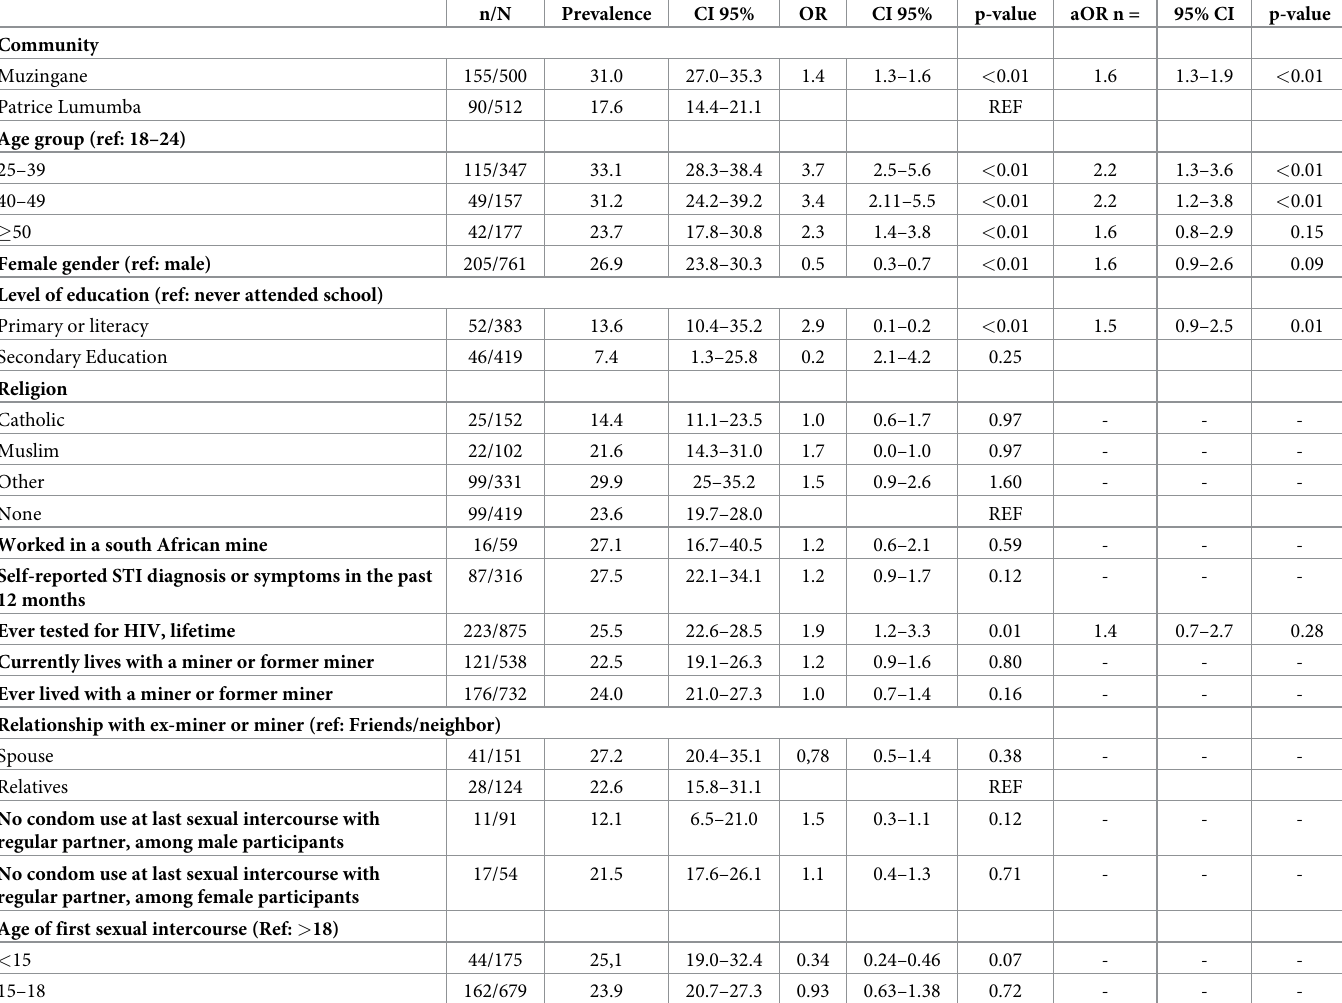
Table 4. HIV Prevalence by socio-demographic characteristics and behavior characteristics in miners community of origin, Gaza Province, Southern of Mozam- bique,